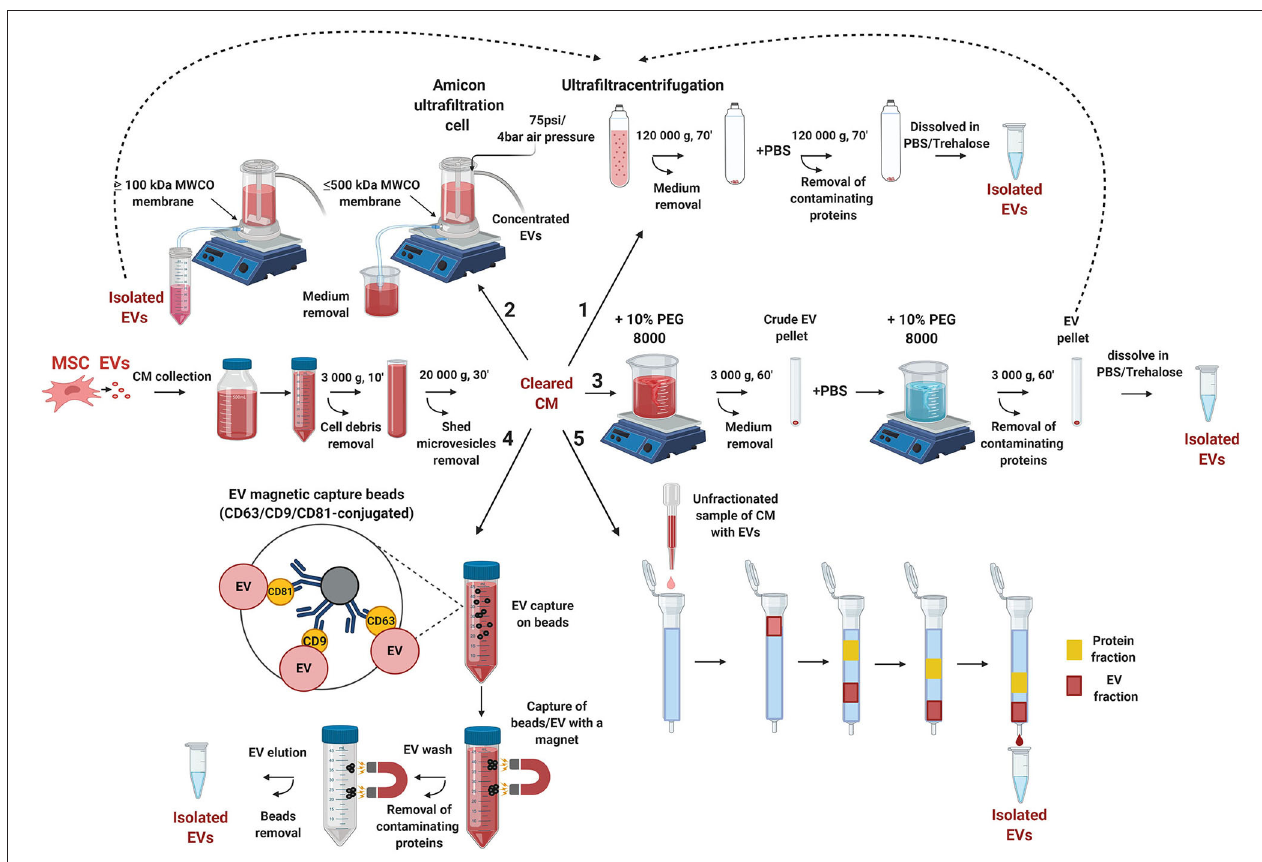
FIGURE 3 | Overview of different methodological approaches for isolation and purification of EVs. MSC-EVs secreted into a cell culture supernatant are collected as EV-conditioned medium (CM). All EV isolation protocols start with sequential low-speed centrifugation steps, to remove cell debris and large shed microvesicles. Next, the cleared CM can undergo either ultracentrifugation ( 1 ), ultrafiltration ( 2 ), precipitation with PEG ( 3 ), immune-immobilization ( 4 ), or size-exclusion chromatography ( 5) protocols resulting in isolated EV fractions. ( 1 ) CM is subjected to ultracentrifugation at 120 000 × g. For removing contaminating proteins, the EV pellet is additionally dissolved in PBS, and the ultracentrifugation step is repeated. ( 2 ) In case of ultrafiltration, the CM is passed through a membrane with pore sizes over 500 kDa MWCO by air pressure application. This results in concentrated CM with reduced serum protein and lipoprotein content. Next, the concentrated CM can either be subjected to a next round of ultrafiltration, using a membrane with pores ≤ 100 kDa MWCO, to retain and capture EVs, or, alternatively, it can undergo the ultracentrifugation procedure ( 1 ). For the PEG protocol ( 3 ), EVs are precipitated from the CM by 10% PEG in two rounds. The final EV pellet can be additionally purified with subsequent ultracentrifugation steps. For the immunocapture protocol ( 4 ), CD9-, CD63-, or CD81-conjugated magnetic beads are incubated with CM, to capture EVs, which are then immobilized by a magnet. After serial washing steps, the captured EVs are eluted from the beads. In case of size-exclusion chromatography ( 5 ), CM, or concentrated CM, is loaded on a resin-filled column, and the CM content (EVs and medium proteins) is fractionated according to their size. This approach allows isolation of uniformly-sized EV particles. All methods can be used as separate protocols or in various combinations, to fulfill different requirements for downstream analyses and applications utilizing